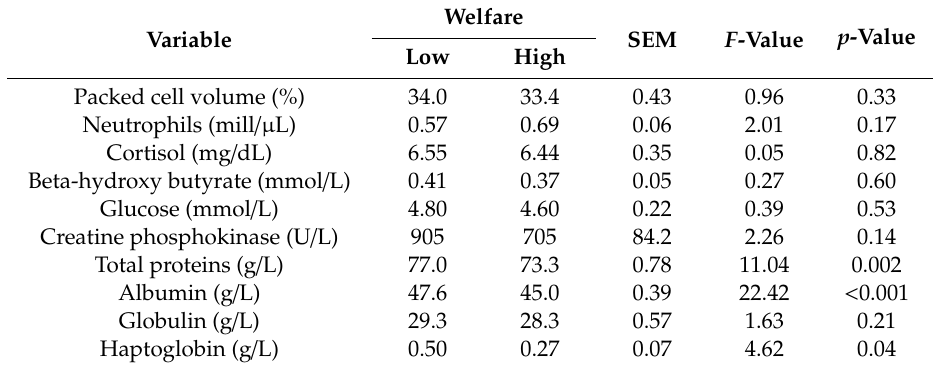
Table 2. Mean concentrations of blood variables of cattle at two di ff erent welfare levels, Low and High. Low 0.66 m 2 / head and High 0.86 m 2 / head. (The standard error of the mean (SEM) was used on the table)